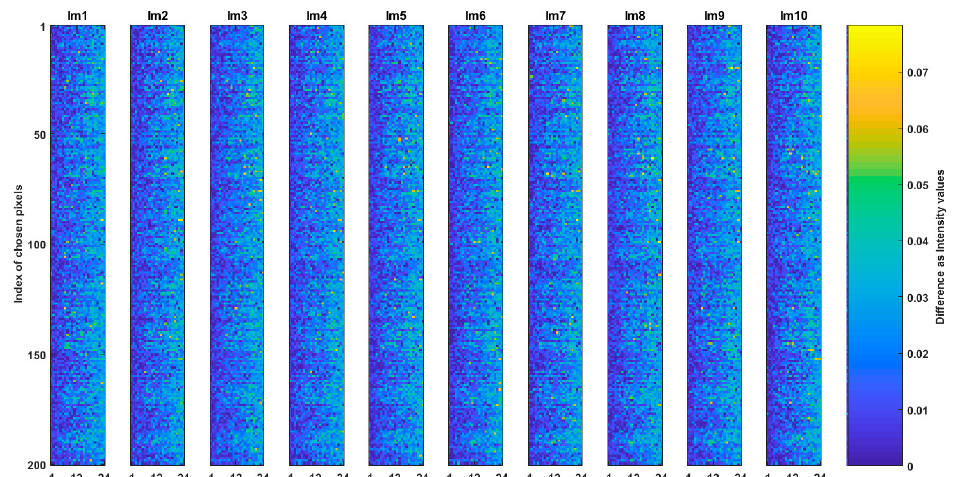
Figure 8. Comparison of the common space of CSE_sq and its originated image of SQ. The absolute intensity value difference of ten SQ p and SQ CEorg are shown.